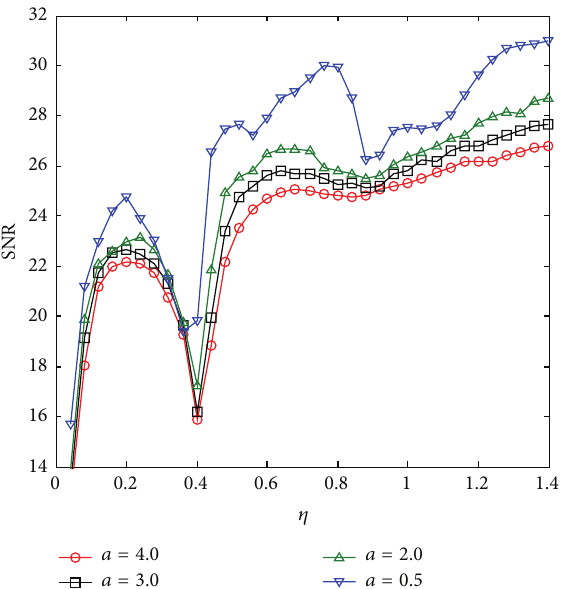
Figure 8: SNR versus the damping coefficient with the different noise intensity of the asymmetric dichotomous